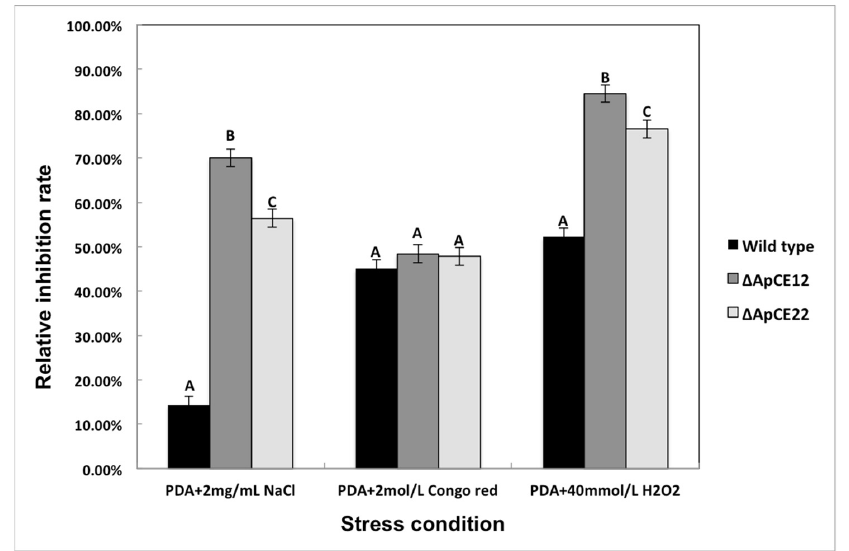
Figure 12. The bar chart shows the relative inhibition rate of wild-type, Δ ApCE12, and Δ ApCE22 strains after NaCl and H 2 O 2 stress for 5 days, respectively. Note: The datasets were calculated from the image in Figure 12. The error bars represent the standard deviations based on three independent biological replicates with three technical replicates each. The relative inhibition rates of Δ ApCE12 and Δ ApCE22 were significantly different from that of the wild type after NaCl and H 2 O 2 stress. The relative inhibition rates of Δ ApCE12 and Δ ApCE22 were consistent with that of the wild type after CR stress. All assays were repeated three times; the data were analyzed using one-way ANOVA and Duncan’s range test in SPSS 16.0. Different capital letters (A, B and C) show that the relative inhibition rates of Congo red, NaCl, and H 2 O 2 on the mycelial growth of different strains were significantly different. ( p ≤ 0.01).